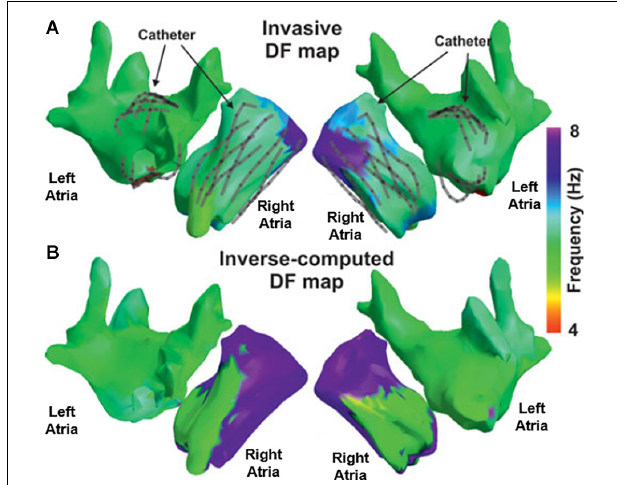
FIGURE 4 | Validation of inverse computed DF maps. Electrocardiographic imaging (ECGI) inversely computed (A) and simultaneously recorded (B) DF maps obtained in a patient in which a multipolar catheter was sequentially placed in the right and left atria. Figure modified from Pedrón-Torrecilla et al.